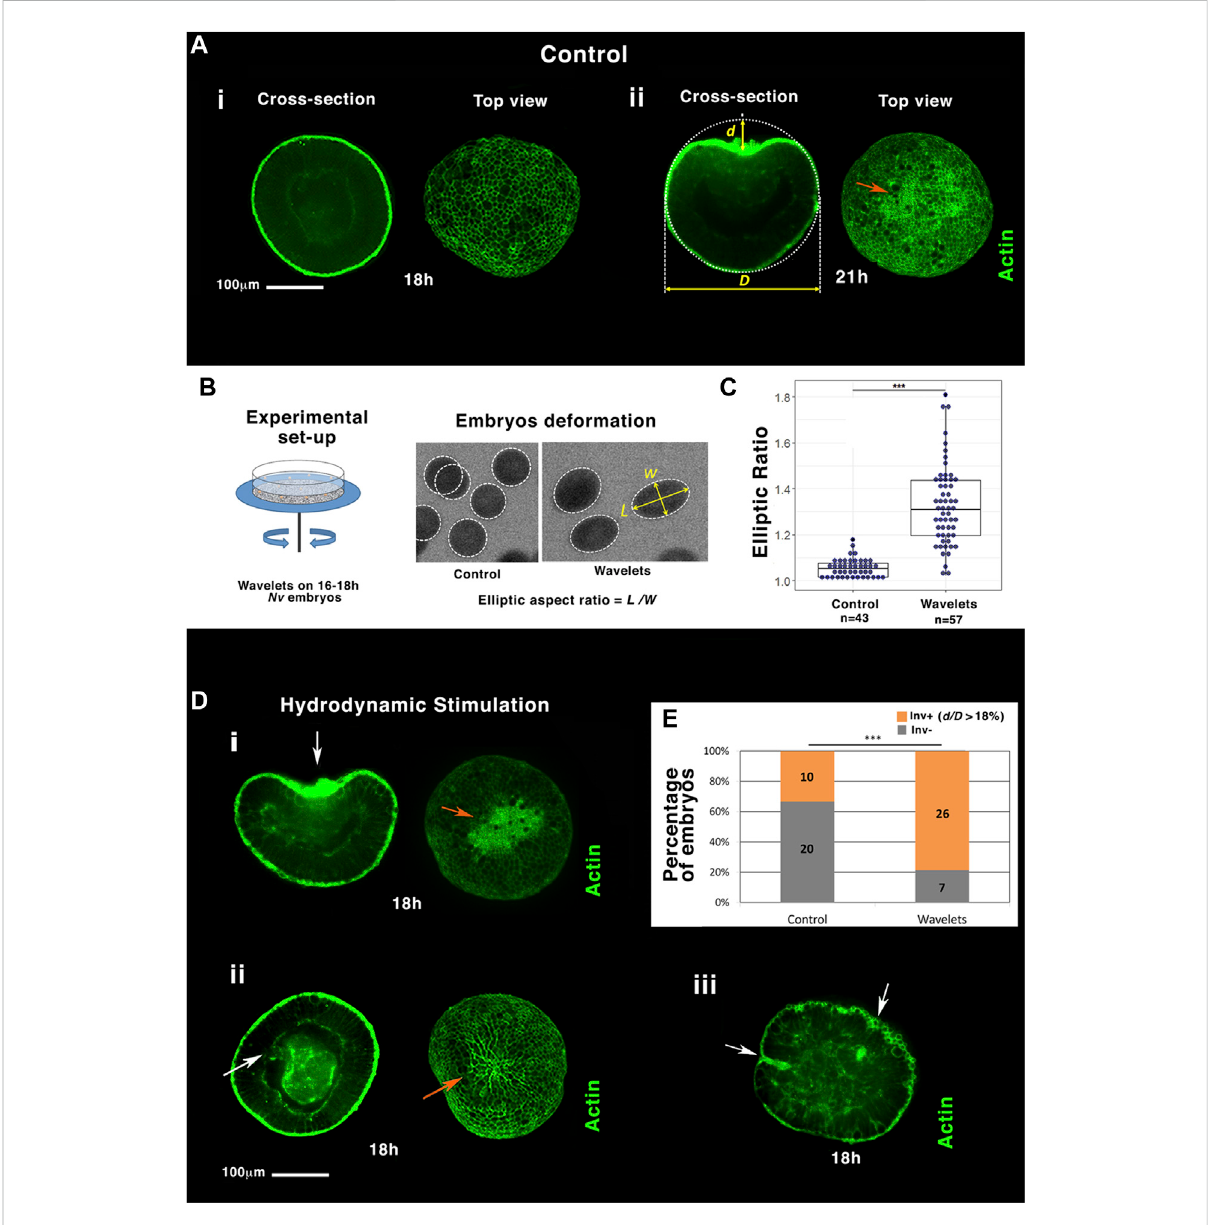
FIGURE 1 Hydrodynamicstimulationof Nematostella embryogastrulationbythemarine fl ow. (A) Themostrepresentativegastrulationstatepopulationof embryos at(i)18 hand(ii)21 h. (B) Setup: mimickingsea ocean streambyshakingaPetridish withsandonitsground.Hydrodynamicdeformationof jelled embryos with sand. (C) Quanti fi cation of the elliptic deformation of embryos. n Control = 43 and n Wavelet = 57, p = 3.10 – 15 . Mann – Whitney statistical test. (D) i,ii, iii: embryos representative of the majority of individuals submitted to the fl ow (see text). White arrows: invaginations. Orange arrows: apex constriction. Scale bar is 100 μ m. (E) Quantitative characterization of the percentage of gastrulating embryos (in orange), submitted to the fl ow compared to control (in grey), based on signi fi cant normalized invagination depth d/D measurement higher to 18% (see text), n Control = 30 and n Wavelet = 33, p = 7.10 – 4 . Fisher statistical test. N = 2 biological replicates (embryo number inside